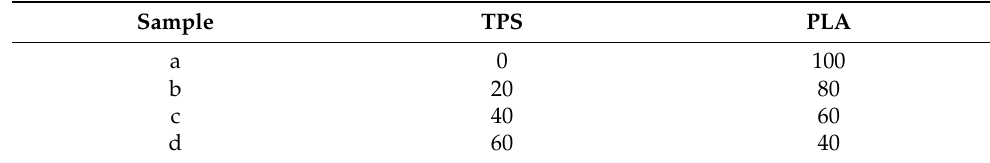
Table 1. Formula of thermoplastic starch/polylactic acid (TPS/PLA blends)